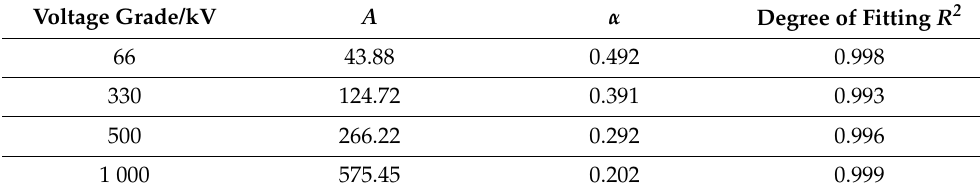
Table 2. Parameters of pollution flashover voltage curve.